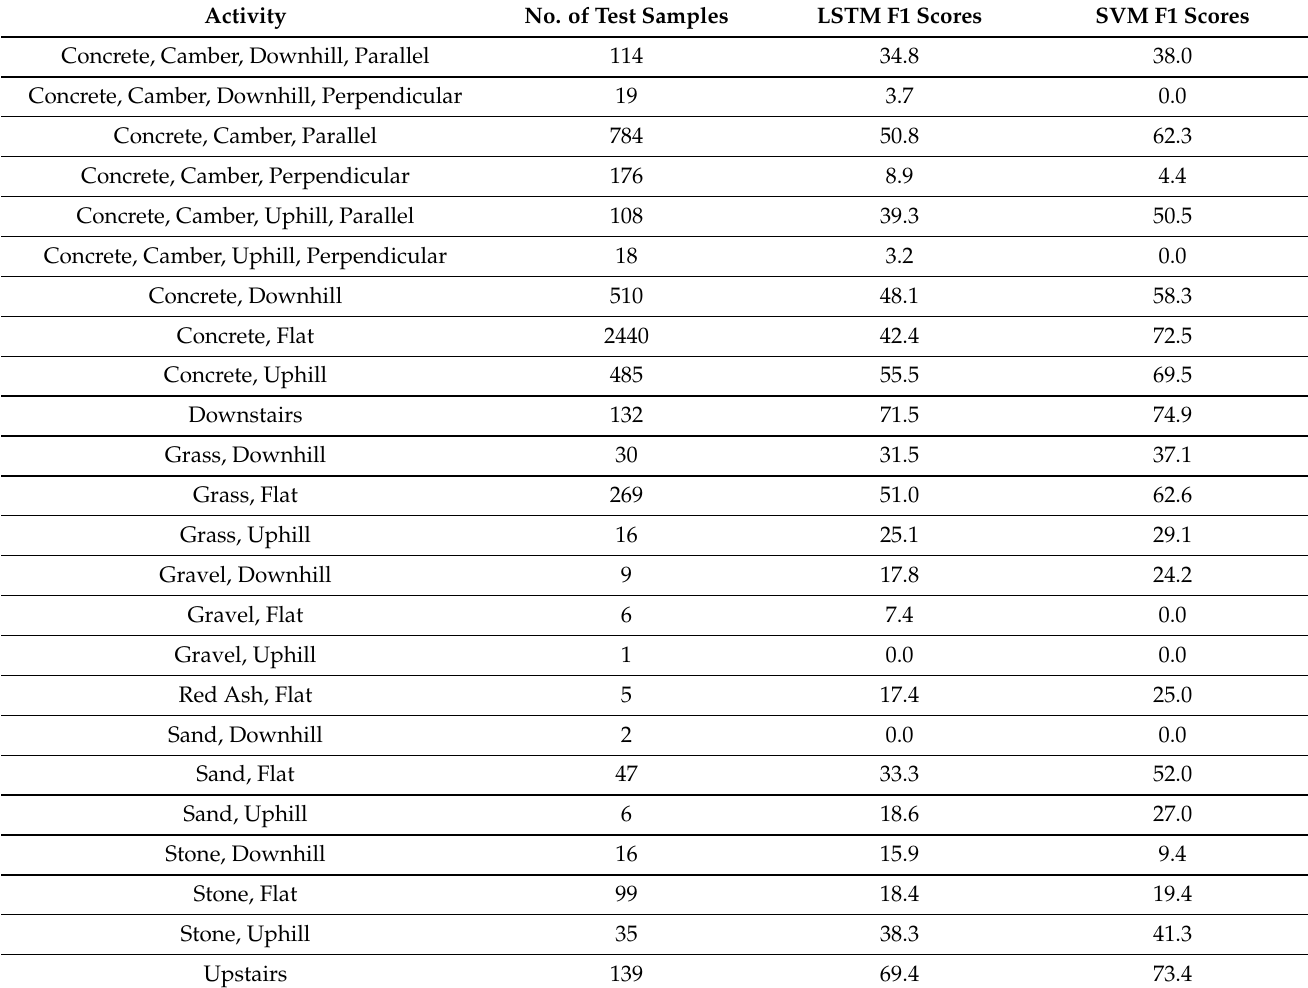
Table 9. Mean F1 Scores for Level 3 Label